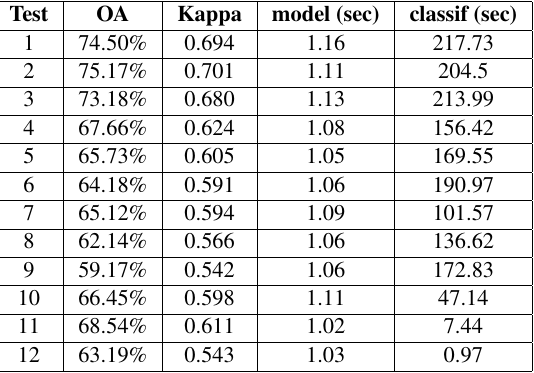
Table 2. Results obtained in classification process - Step 1.